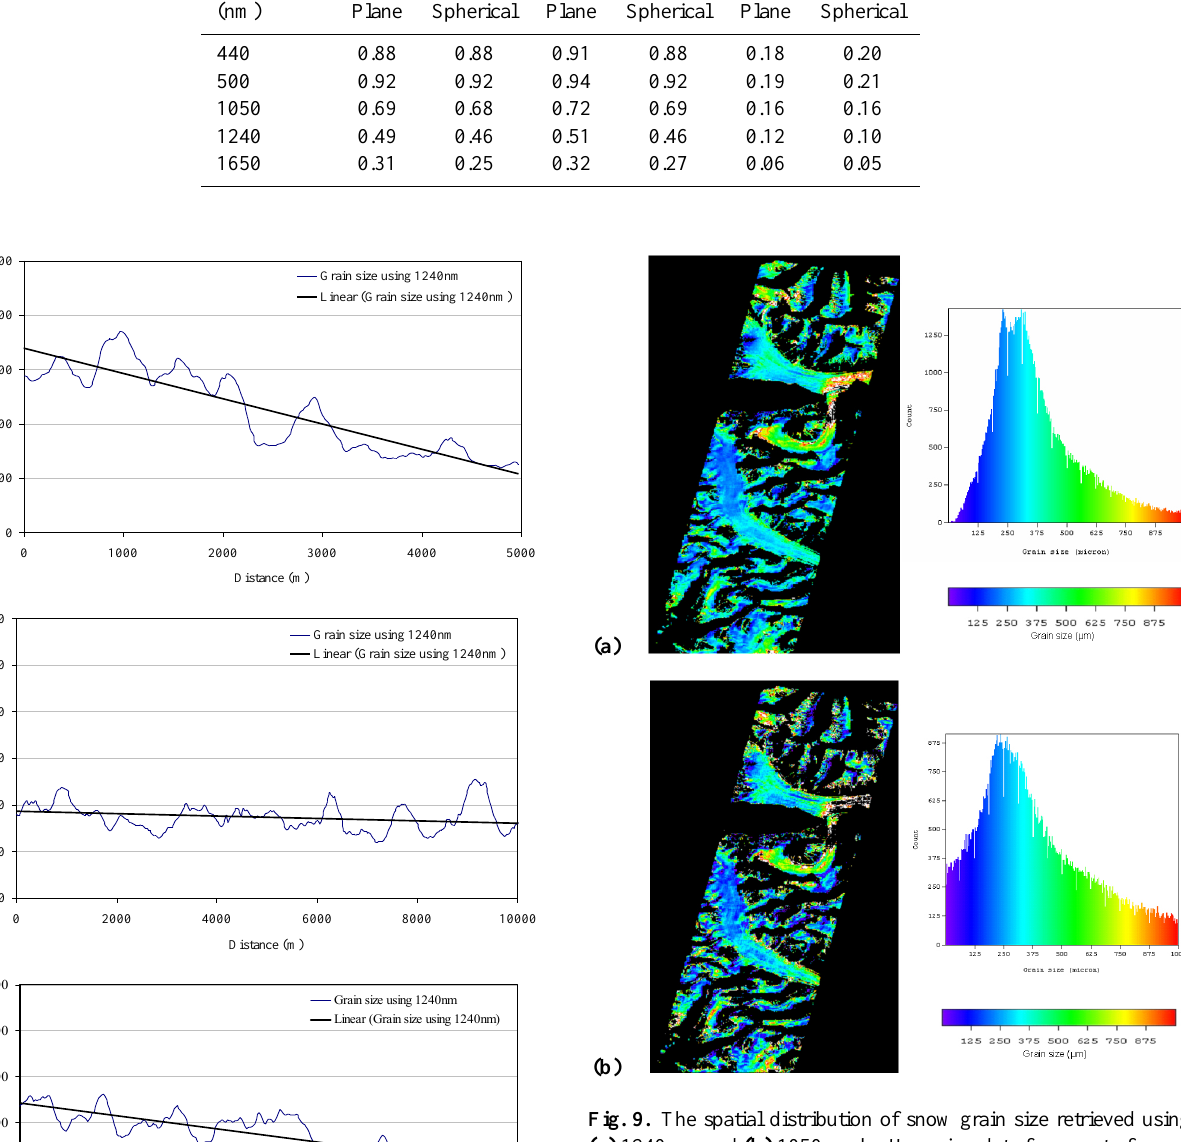
Fig. 9. The spatial distribution of snow grain size retrieved using (a) 1240nm and (b) 1050nm by Hyperion data for a part of upper Himalaya.